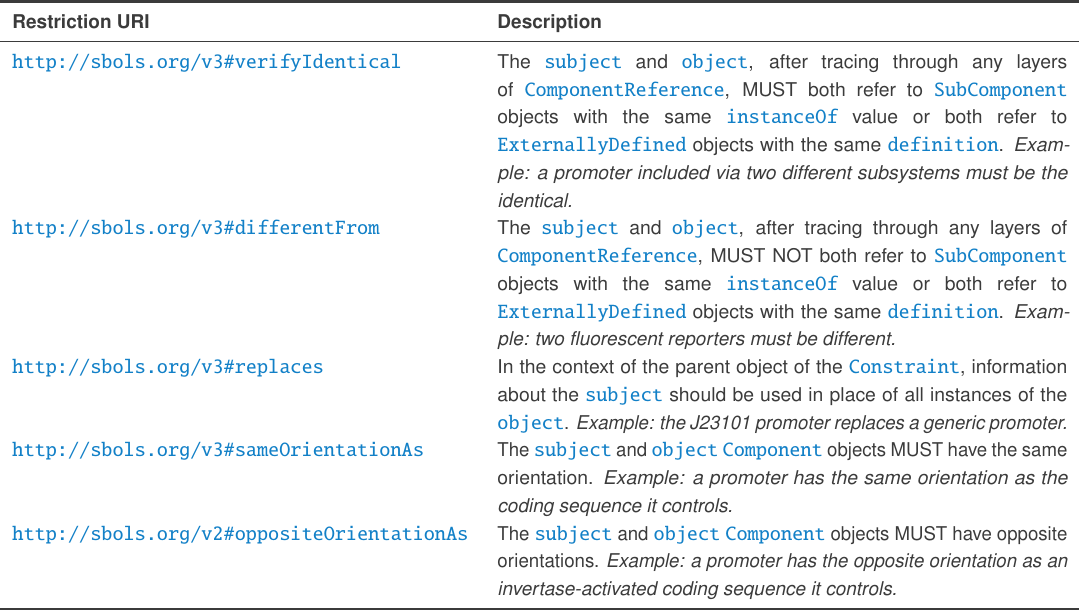
Table 7: RECOMMENDED URI s for expressing identity and orientation with the restriction property.